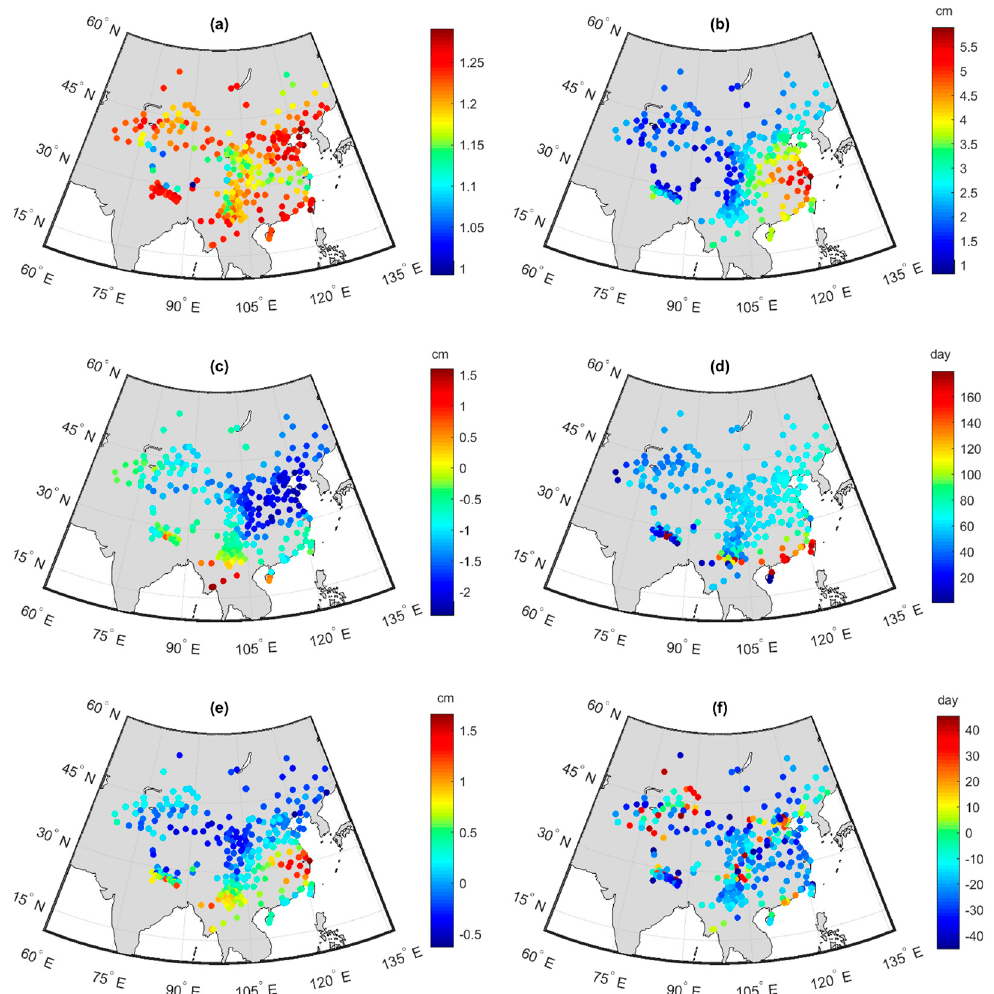
Figure 3. The fit parameters of the absolute ZTD fit residuals. ( a ) the ratio between the RMS of RAW ZTD fit residuals and the RMS of modeled residuals; ( b ) the constant term B 0 ; ( c ) annual amplitude B 1 ; ( d ) initial phase of annual term f 1 ; ( e ) semi-annual amplitude B 2 ; ( f ) initial phase of semi-annual term f 2 .